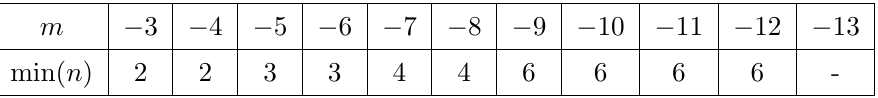
Table 2 . For each m , the minimal value of n such that a section (cid:27) n 2 O ( (cid:0) nK B ) exists preventing (4 ; 6) points over a curve of self-intersection m . Note that since there are no (cid:27) 5 s in any cases (see the third column in table 8), min( n ) jumps from 4 to 6 between m = (cid:0) 8 and m = (cid:0) 9. ( F ) (cid:12)brations over toric base surfaces, which are F (cid:12)brations where all rays in the base 10 10 are stacked over a speci(cid:12)c vertex v of F . This simple class of (cid:12)brations corresponds s 10